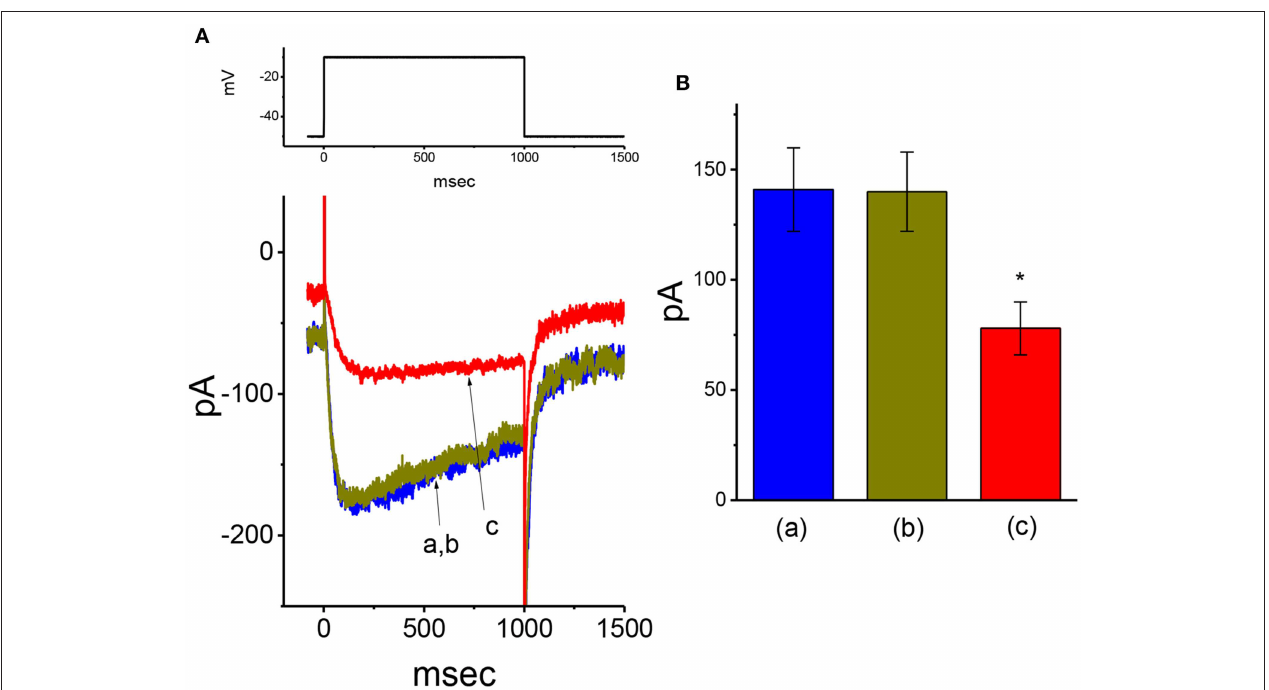
FIGURE 4 | Failure of VP to alter M-type K + current ( I K(M) ) recorded from GH 3 cells. In these experiments, we bathed cells in high-K + , Ca 2 + -free solution, and filled the pipette by using K + -containing solution. (A) Original I K(M) traces in response to long-lasting membrane depolarization from − 50 to − 10mV. a: control; b: 10 µ M VP; c: 10 µ M VP plus 3 µ M pioglitazone. The voltage protocol used is indicated in the upper part. (B) Summary bar graph showing the effect of VP and VP plus pioglitazone on I K(M) elicited by membrane depolarization (mean ± SEM; n = 11 for each bar). *Significantly different from control ( P <